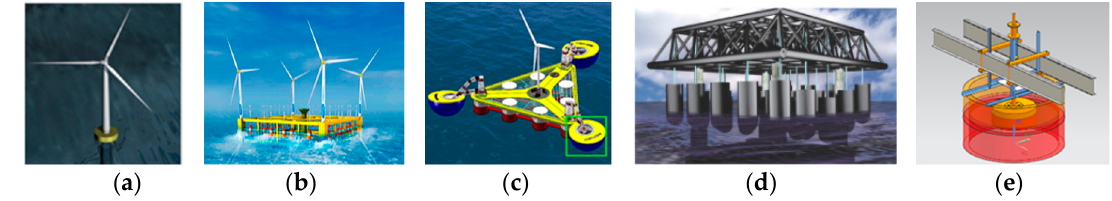
Figure 1. The typical ocean platform-point-absorption wave energy converters (PAWEC) devices. ( a ) Adapted from reference [6]; ( b ) Adapted from reference [8]; ( c ) Adapted from reference [9]; ( d ) Adapted from reference [10] and ( e ) Adapted from reference [14].